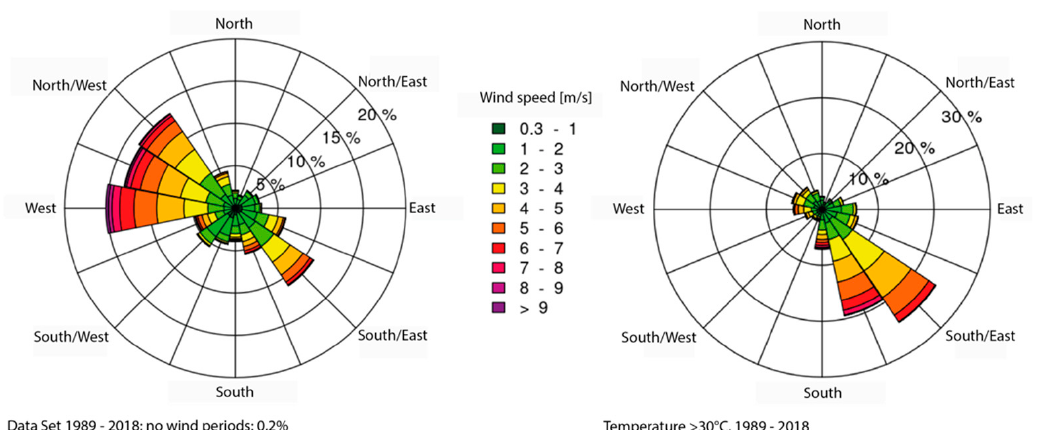
Figure 4. Windrose diagrams: Average wind speeds (color) and directions (bars) observed at the inner city weather station in Vienna for all weather situations ( left ) and for hours with temperatures > 30 °C ( right ).